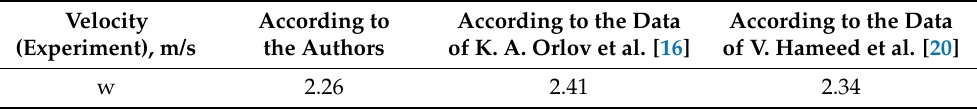
Table 3. Comparison of the experimental data of the authors at a temperature of 120 ◦ C. Velocity According to According to the Data According to the Data (Experiment), m/s the Authors of K. A. Orlov et al. [16] of V. Hameed et al. [20] w 2.26 2.41